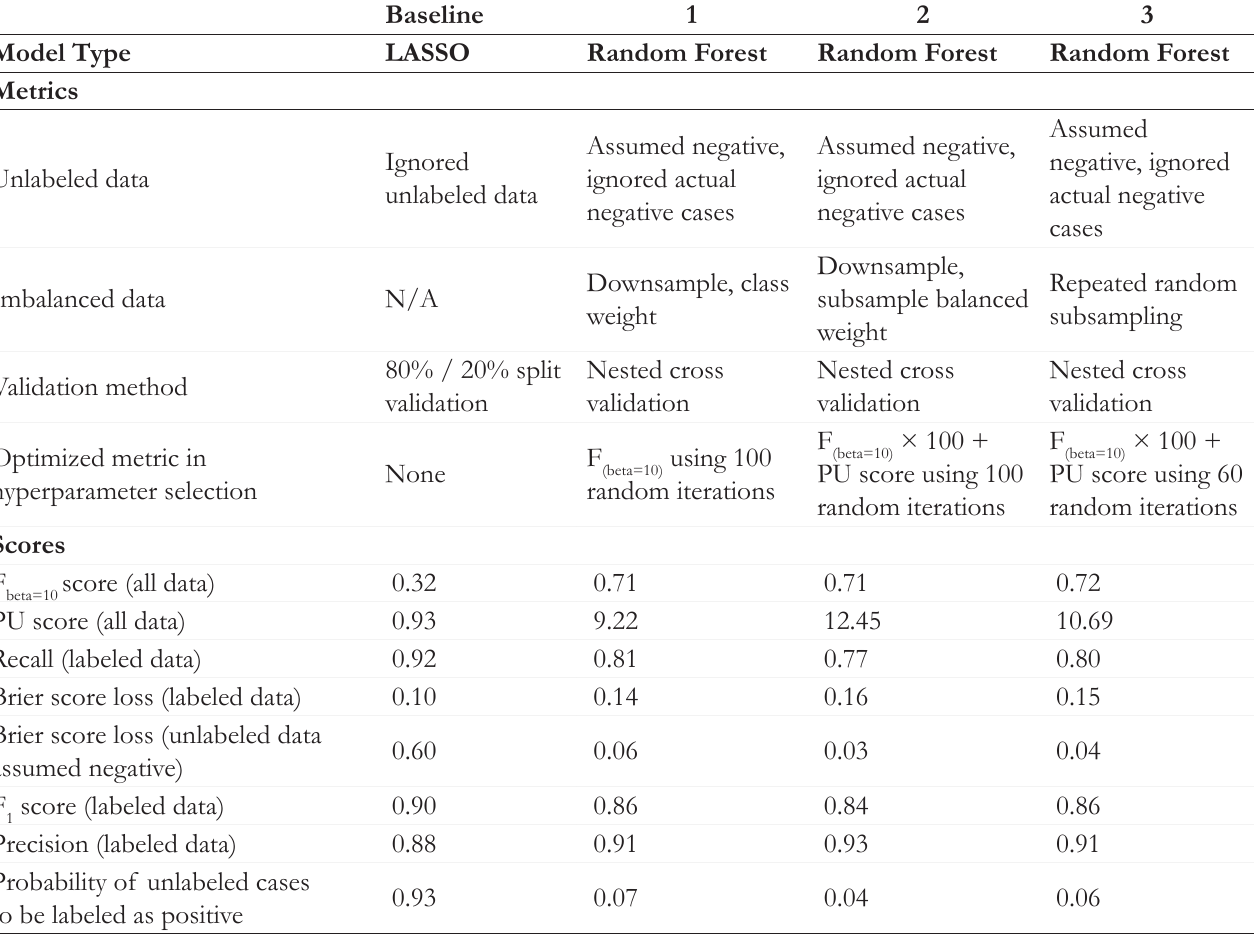
Table 3. Results of Baseline and High-performing